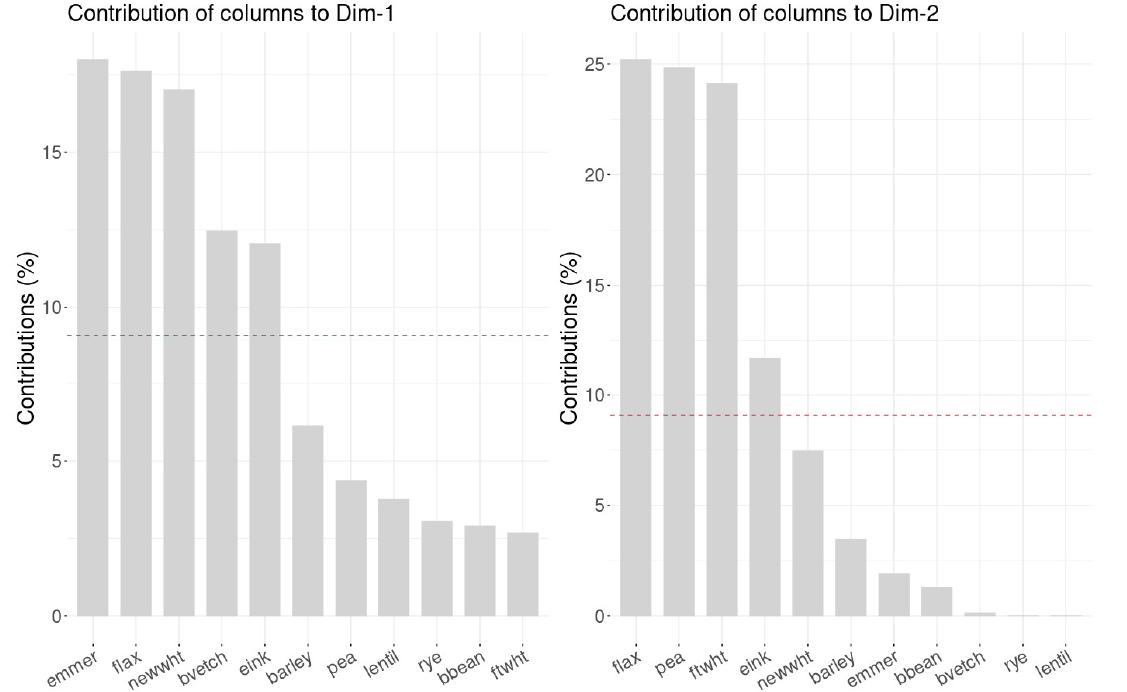
Figure 8. Percentage contributions of crops to dimensions 1 and 2 in Figure 7. Table 1. Vernacular names and Latin binomials of the taxa included in the correspondence analyses.